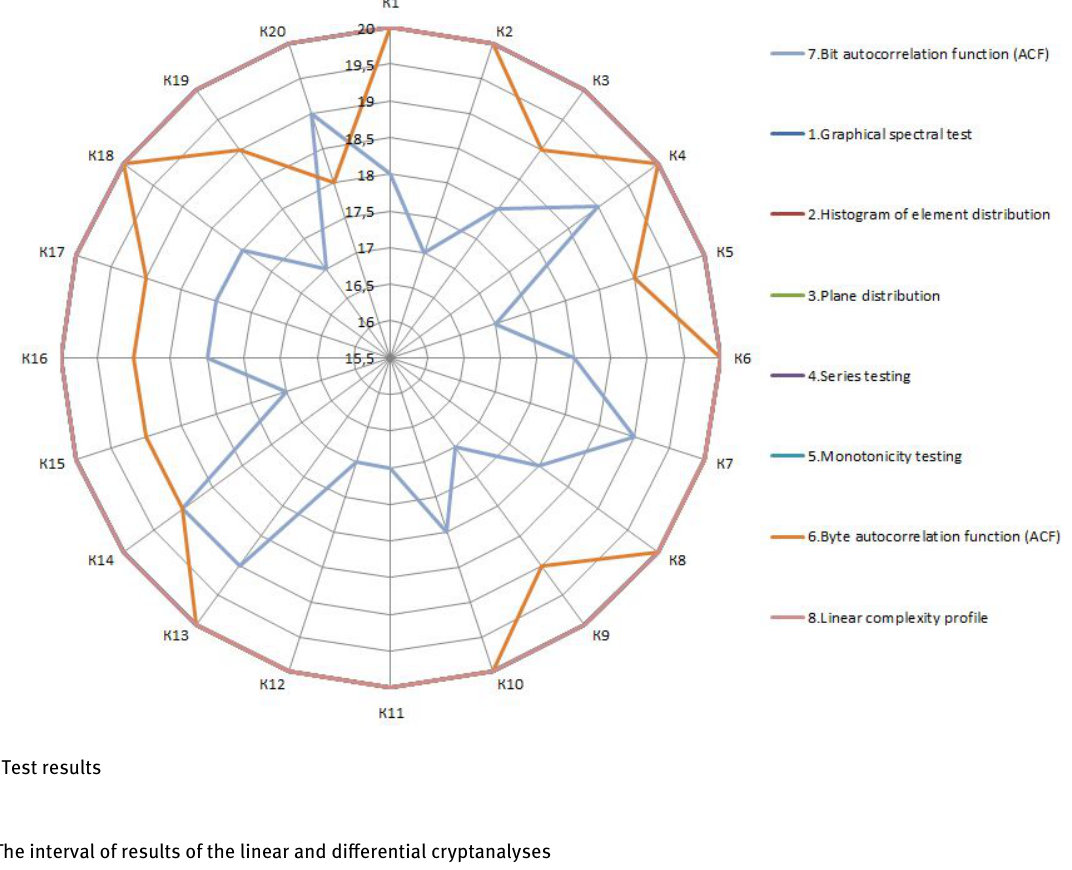
Table 2: The interval of results of the linear and differential